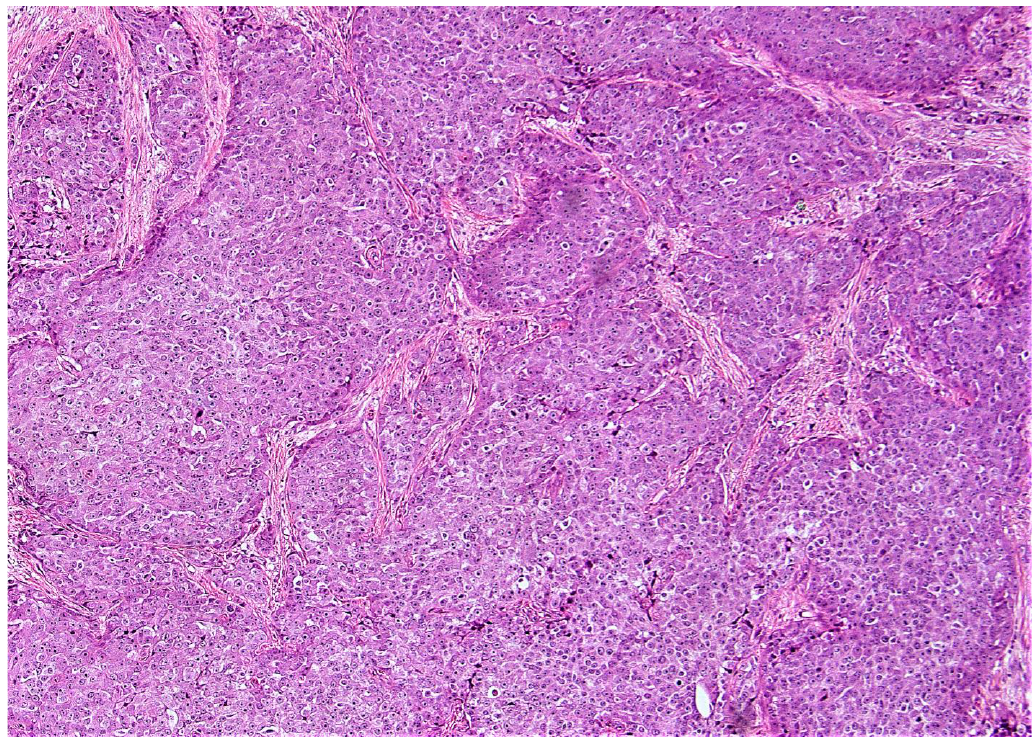
Figure 6. (10×): Example of a low-risk ODX patient considered to be higher-risk by the aMMs, with a breast cancer recurrence (Supplemental Table S2—case # 3) Note the higher grade histologic qualities. This patient was 67 years of age with an aMMs of 21.1, a Ki-67 of 15%, and an ODX recurrence score of